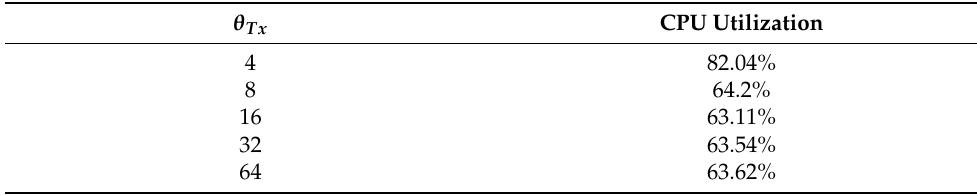
Table 3. The CPU utilization of the data plane at 10 Gbps for different θ Tx .